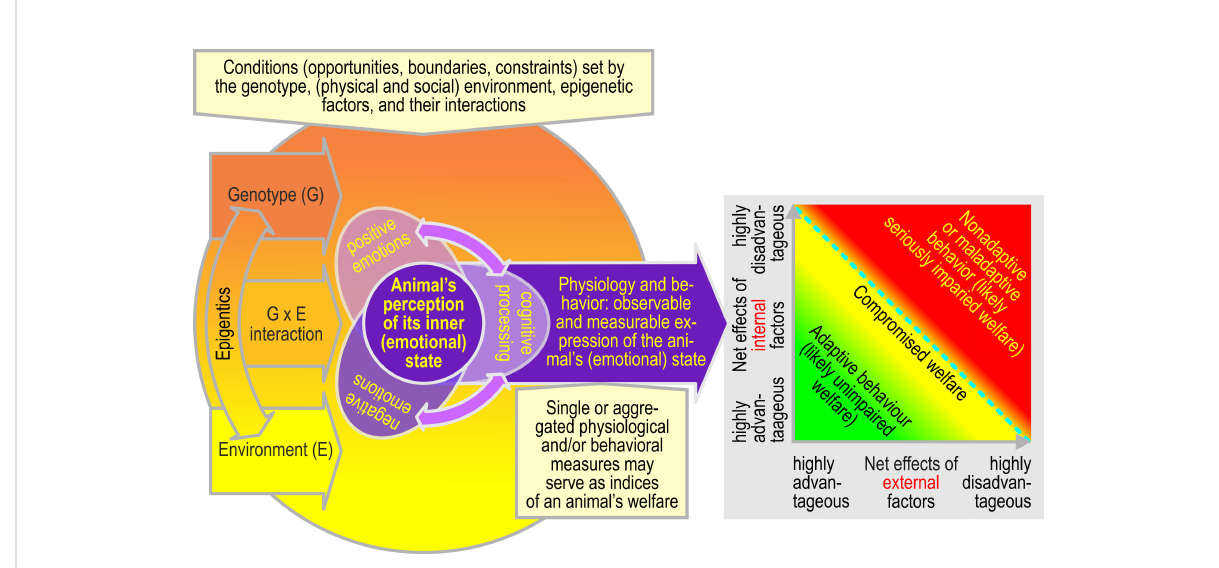
FIGURE 2 Perception of the inner (emotional) state and adaptability to internal and external factors. Left panel: An individual ’ s emotions and cognitive abilities and the resultant overt behavior and physiological reactions are controlled by its genotype, its environment, and the interaction of genotype and environment. We de fi ne welfare as a state that the animal perceives as positive (Ohl et al., 2009; Ohl and van der Staay, 2012). The perception of its inner state is determined by the interplay of positive and negative emotions and cognitive processes, where emotions may modulate cognition and vice versa (indicated by double-headed purple arrows: emotions modulate cognitive processes and vice versa). Cognitive or judgment bias tasks, for example, explicitly make use of the interaction between emotions and cognition to assess an animal ’ s emotional state (Bateson, 2016; Roelofs et al., 2016; Roelofs and van der Staay, 2017). Right panel: The net impact of internal and external factors in interaction with an animal ’ s speci fi c genetic background, determine the adaptability needed by an individual. The limit of adaptability is, within certain bounds, dynamic and determined by, for example, hormonal changes, long-term effects of speci fi c experiences, and, in social animals, the status/position in the group, herd, or fl